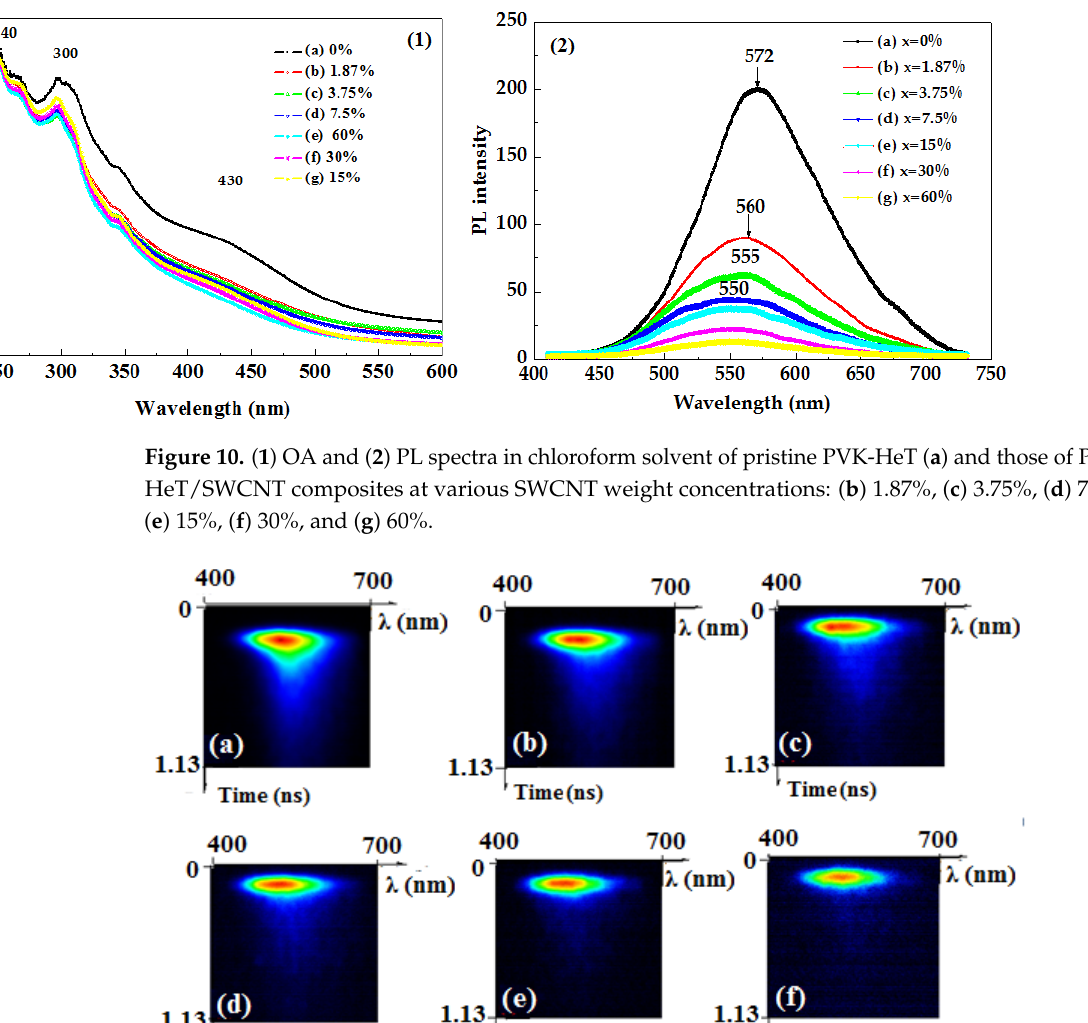
Figure 10. ( 1 ) OA and ( 2 ) PL spectra in chloroform solvent of pristine PVK-HeT ( a ) and those of PVK-HeT/SWCNT composites at various SWCNT weight concentrations: ( b ) 1.87%, ( c ) 3.75%, ( d ) 7.5%, ( e ) 15%, ( f ) 30%, and ( g ) 60%.